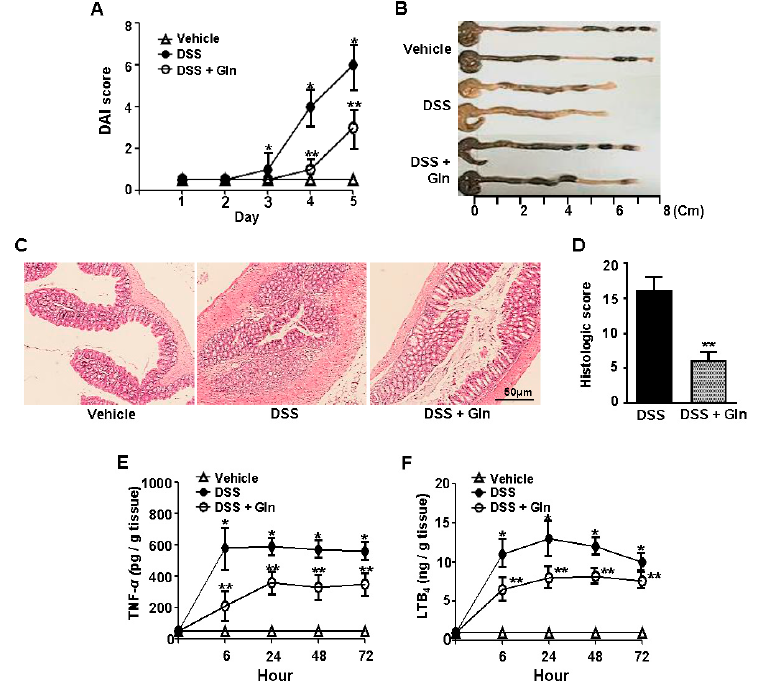
Figure 1. Oral L -glutamine (Gln) intake improves DSS-induced acute colitis. ( A ) Disease severity; ( B ) the colon length on day 5; ( C ) histological examination on day 5; ( D ) histological score; ( E , F ) colonic levels of TNF- α and LTB 4 at 24 h; Data in ( A , E , F ) represent the means ± SEM of three independent experiments ( n = 5 mice/group/time point); ( B – D ) A representative from three independent experiments ( n = 3 mice/group/time point) is shown. Scale bar = 50 μ m. * p < 0.001 vs. vehicle group; ** p < 0.05 vs. DSS group in ( A , D – F ).